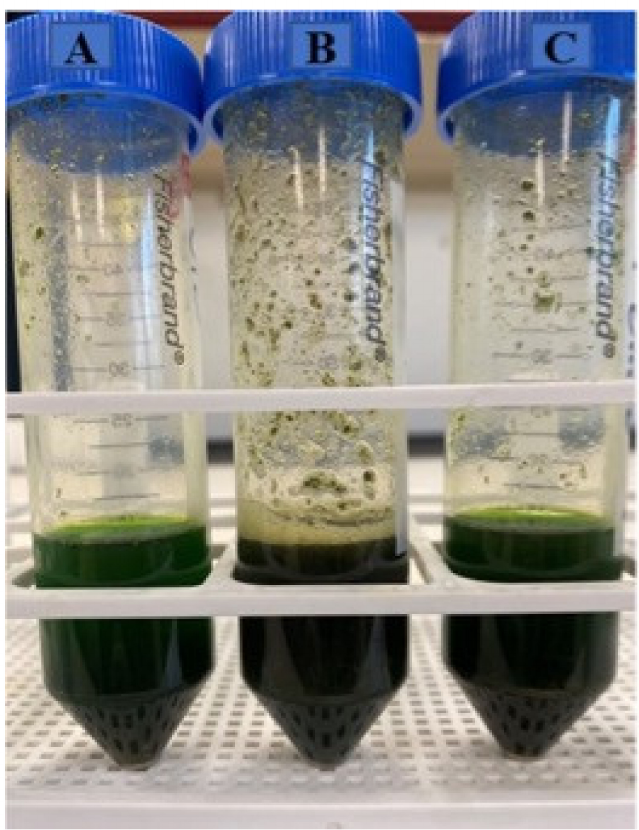
Figure 1. Samples of methanolic (A), aqueous (B) and ethanolic (C) extracts from nettle